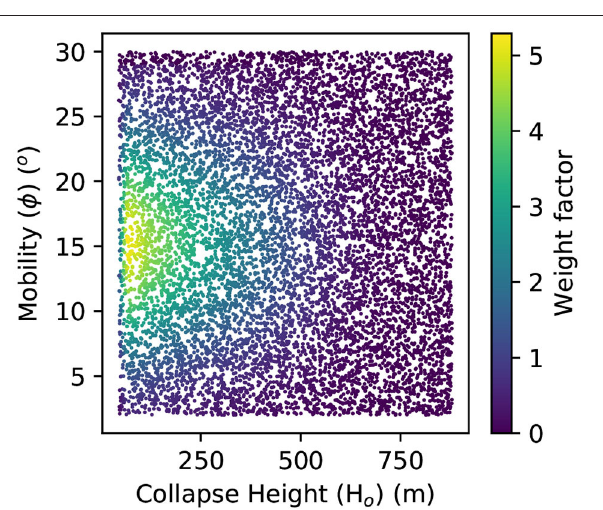
FIGURE 9 | Weighting factors associated with each of the 10,000 collapse height-mobility parameter pairs for energy cone simulations at Aluto. Uniformly distributed parameter pairs are simulated in the energy cone model at each vent, and then the desired weighting can be applied retrospectively. This allows updated collapse height and mobility distributions to be included in future PVHAs without having to re-run the time consuming energy cone